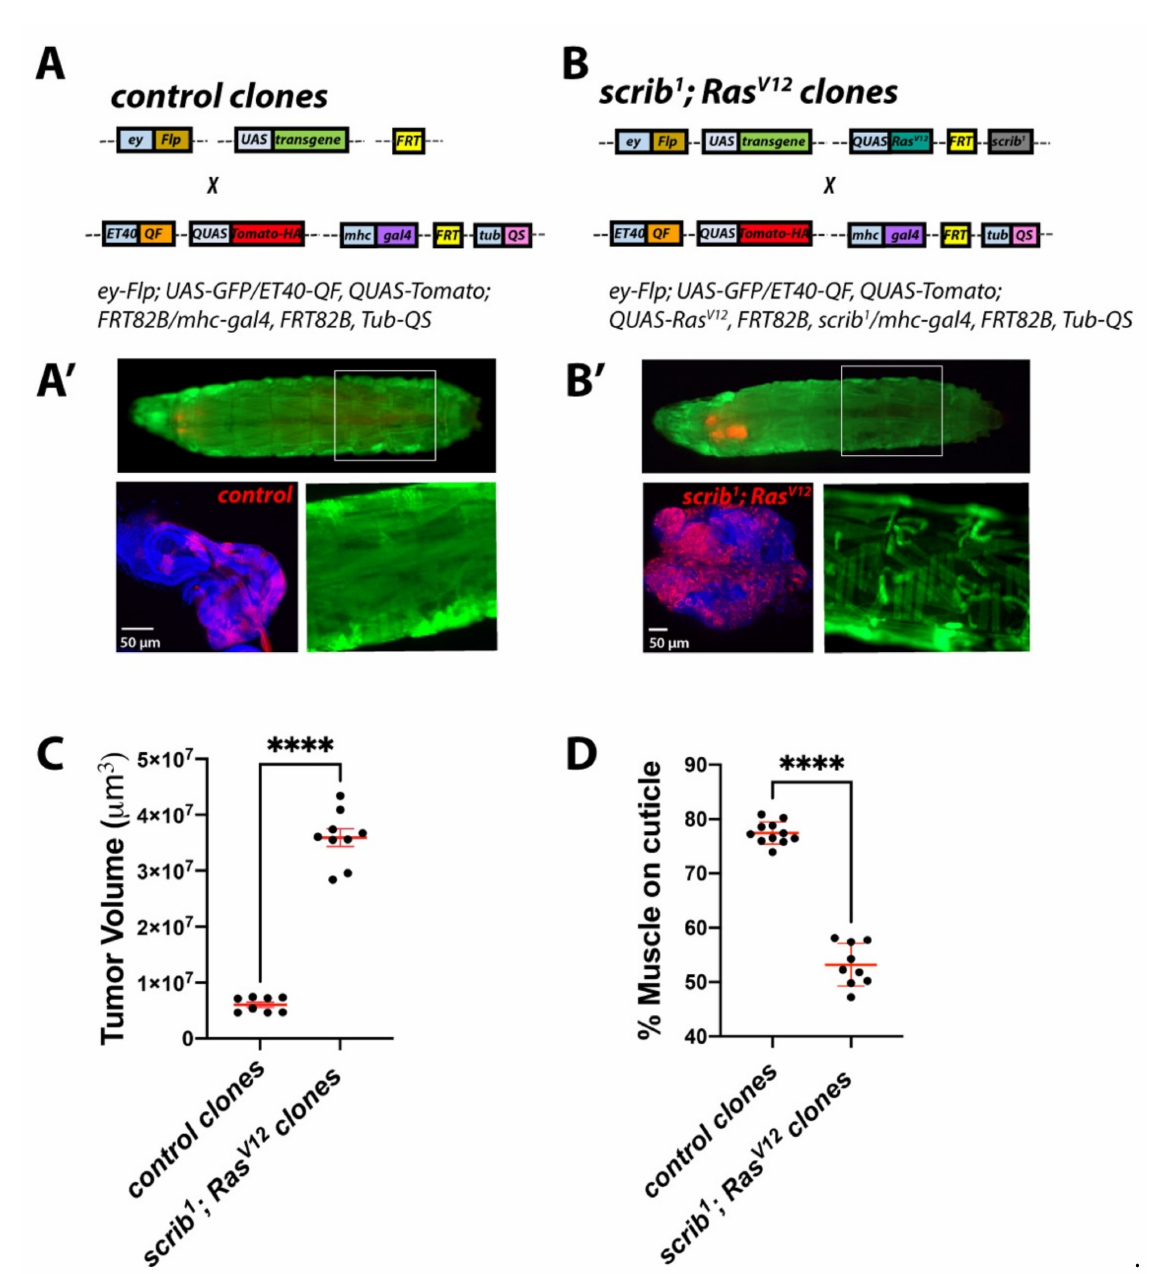
Figure 5. Generation of a dual driver system for independent genetic manipulation of skeletal muscle and larval imaginal discs. ( A , B ) Schematic of the genetic components of a dual driver system used for genetic manipulation of skeletal muscle in larvae bearing eye/antennal disc control or Ras V12 , scrib 1 clones. The imaginal disc driver ET40-QF was used to drive QUAS-tomato with and without QUAS-Ras V12 for the generation of Srcib ; Ras V12 MARCM clones and mhc-gal4 was used for UAS-transgene expression in the skeletal muscle. ( A (cid:48) , B (cid:48) ) Larvae with dual driver system generated control ( A (cid:48) ) or scrib 1 ; Ras V12 clones ( B (cid:48) ) (red; in larvae and bottom left panels) and muscle specific concomitant overexpression of UAS-gfp (green; in larvae and bottom right panels). Boxed areas within larval images delineate magnified views of muscle (bottom right panels). Full genotypes are indicated on top of immunofluorescence images. 6-day-old control ( A (cid:48) ) and 10-day-old scrib 1 ; Ras V12 larvae ( B (cid:48) ). ( C , D ) Quantification of tissue volume ( C ) and percentage of the cuticle covered by muscle ( D ) in animals of ages and genotypes as in ( A (cid:48) , B (cid:48) ). All graphs show t test. Mean ± SEM is indicated. **** p ≤